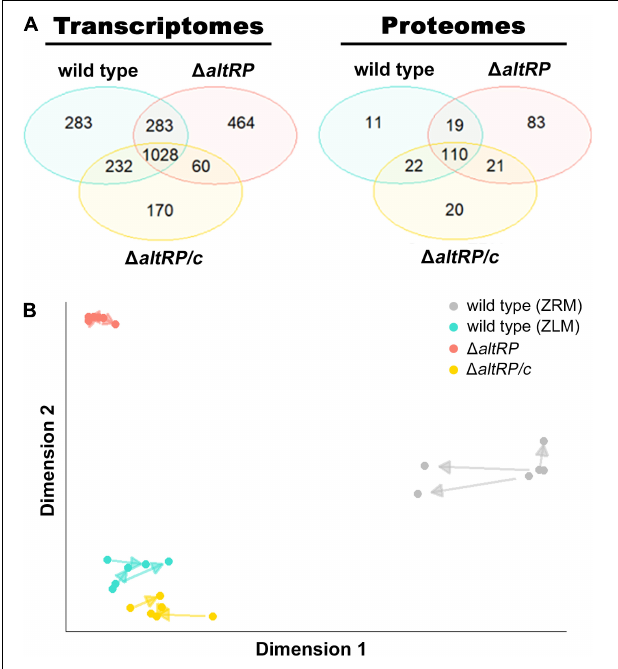
FIGURE 3 | Transcriptomes and proteomes of Zn 2 + -limited wild type, (cid:49) altRP and (cid:49) altRP/c compared to the Zn 2 + -replete wild type. (A) Venn diagrams showing the overlap of DE genes (left) and proteins (right) in the wild type, (cid:49) altRP , and (cid:49) altRP /c (grown in ZLM) when compared to the wild type grown in ZRM. (B) Arrow plot from PLS analysis of the transcriptomes and proteomes of the wild type, (cid:49) altRP , (cid:49) altRP /c (grown in ZLM) and the wild type grown in ZRM. The representation space maximizes the covariance of the components, and as such the scale is arbitrary and absolute values do not affect the